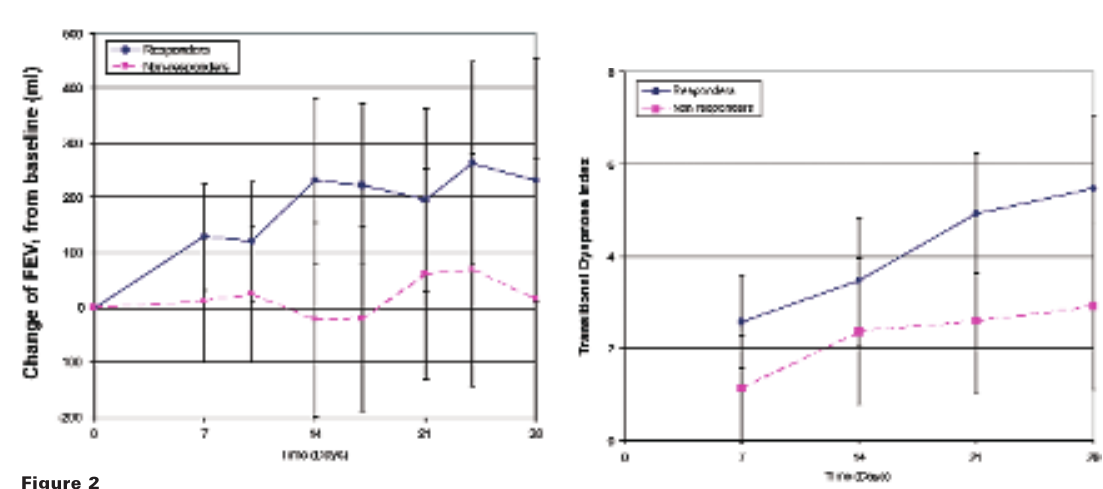
Figure 5 Total transitional dyspnoea score during an oral cortico- steroid trial. Mean ± 95% confidence interval. Responders n = 17; non- responders n =